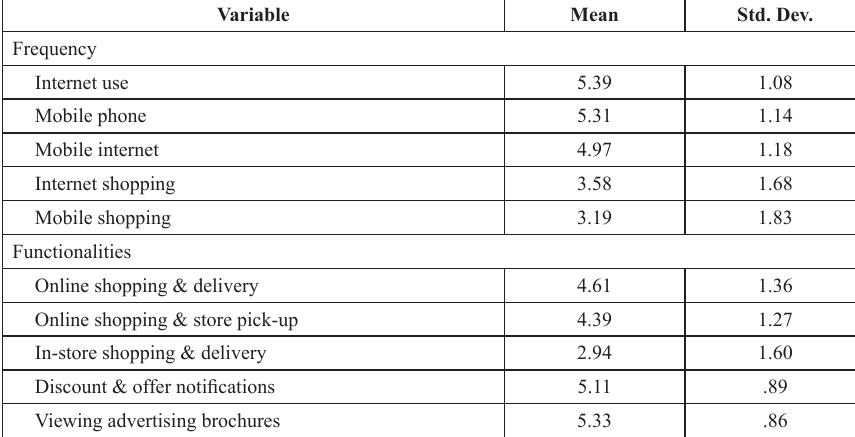
Table 2. Descriptive data of cluster 2 (N =